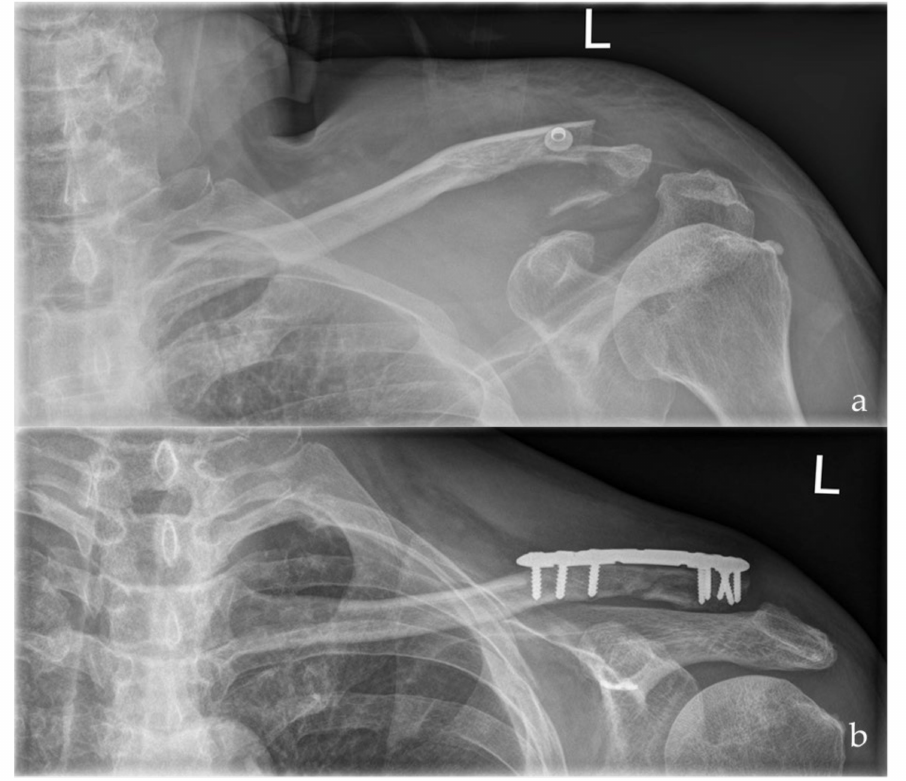
Figure 2. Preoperative ( a ) and postoperative ( b ) radiographs of a left sided multi-fragmentary, displaced lateral clavicle fracture (Neer IIb) after arthroscopic assisted ORIF using a LCP and the knotless DogBone Technique (Group